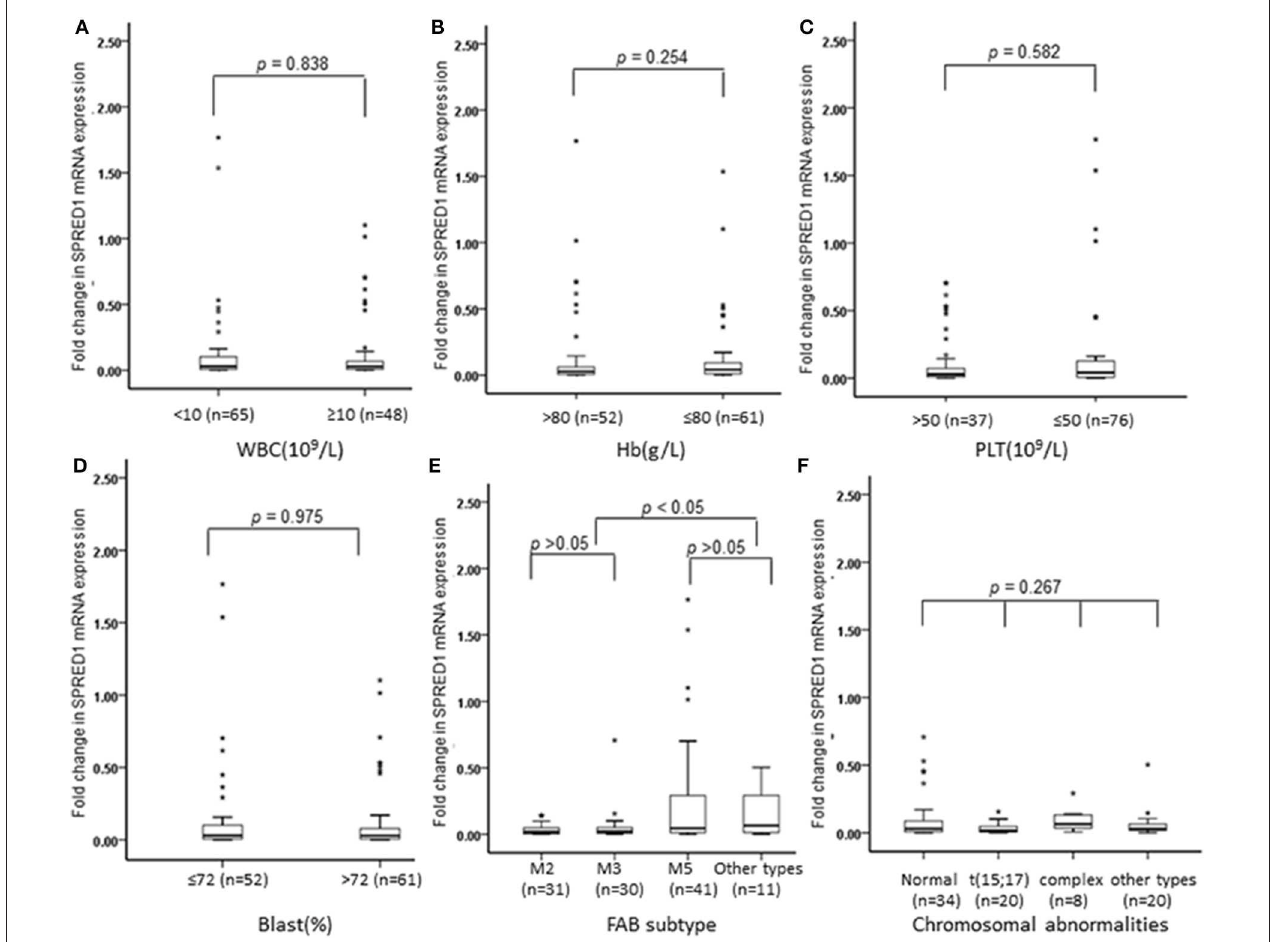
FIGURE 2 | Box plots of SPRED1 mRNA expression in AML patients with different characteristics. SPRED1 mRNA expression in AML patients with different (A) WBC (Wilcoxon tests); (B) Hb (Wilcoxon tests); (C) PLT (Wilcoxon tests); (D) blast (Wilcoxon tests); (E) FAB subtype (Kruskal–Wallis test); (F) chromosomal abnormalities (Kruskal–Wallis